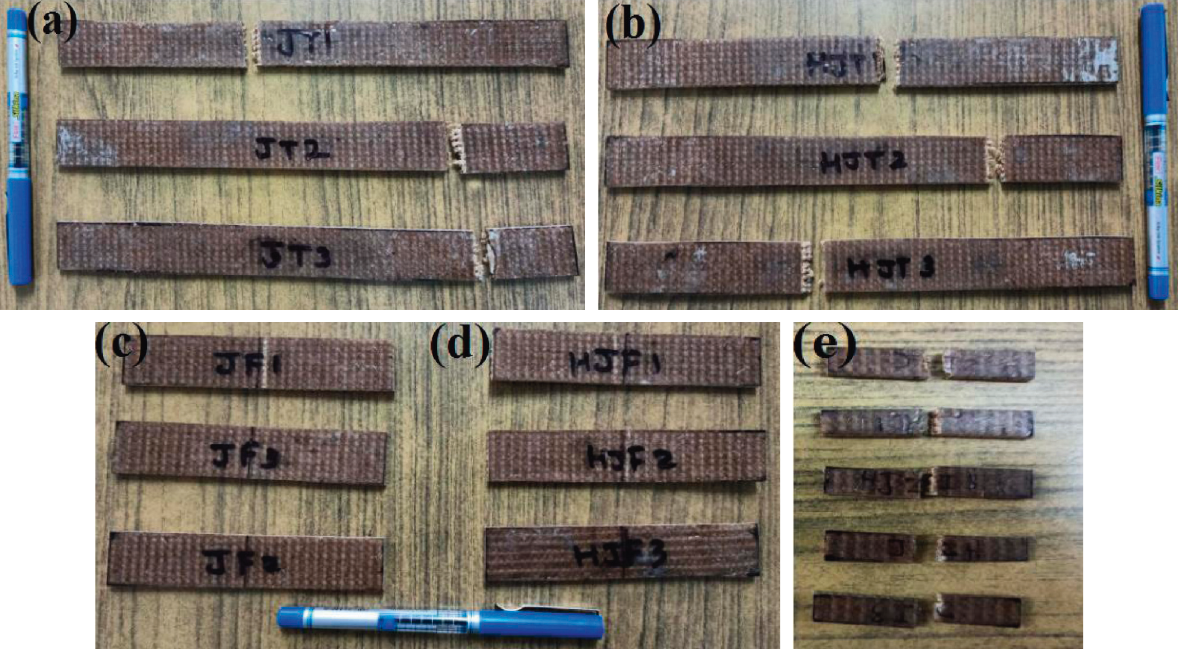
Figure 10: Jute fabric-reinforced composites. (a) Untreated-fractured tensile specimens. (b) Heat-treated-fractured tensile specimens. (c) Untreated-fractured flexure specimens. (d) Heat-treated-fractured specimens undergo flexural failure. (e) Impact test fractured